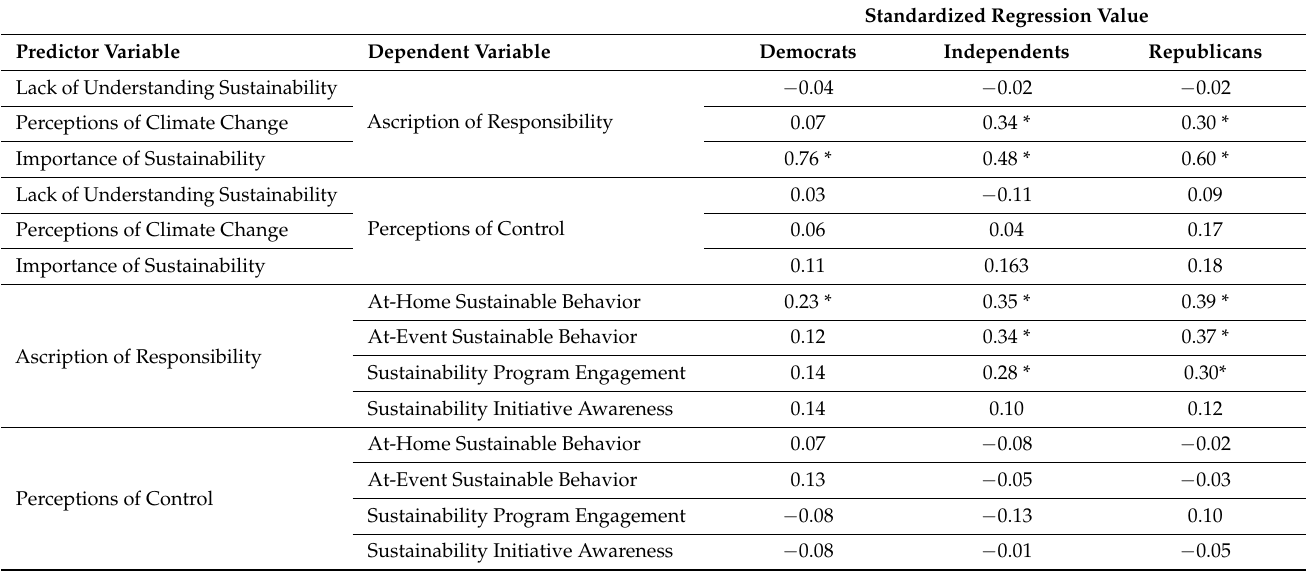
Table 5. Multigroup Path Analysis Examining Values, Norms, and Behaviors Based on Political Party.